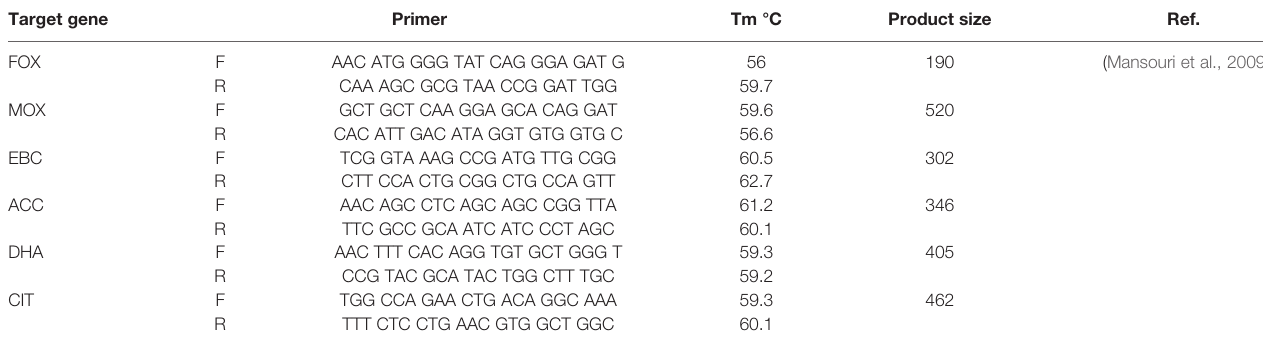
TABLE 1 | Primer sequences for AmpC genes. Target